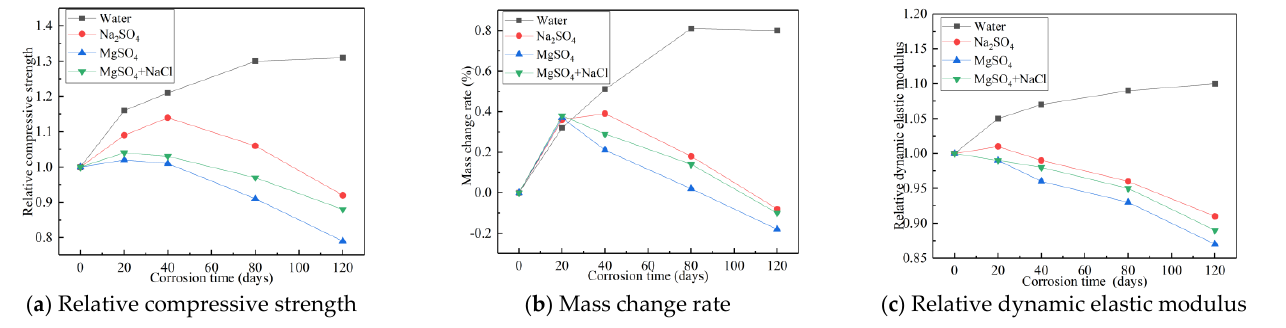
Figure 5. Influences of SO 4 2− on the Physical Properties of MK Concrete.